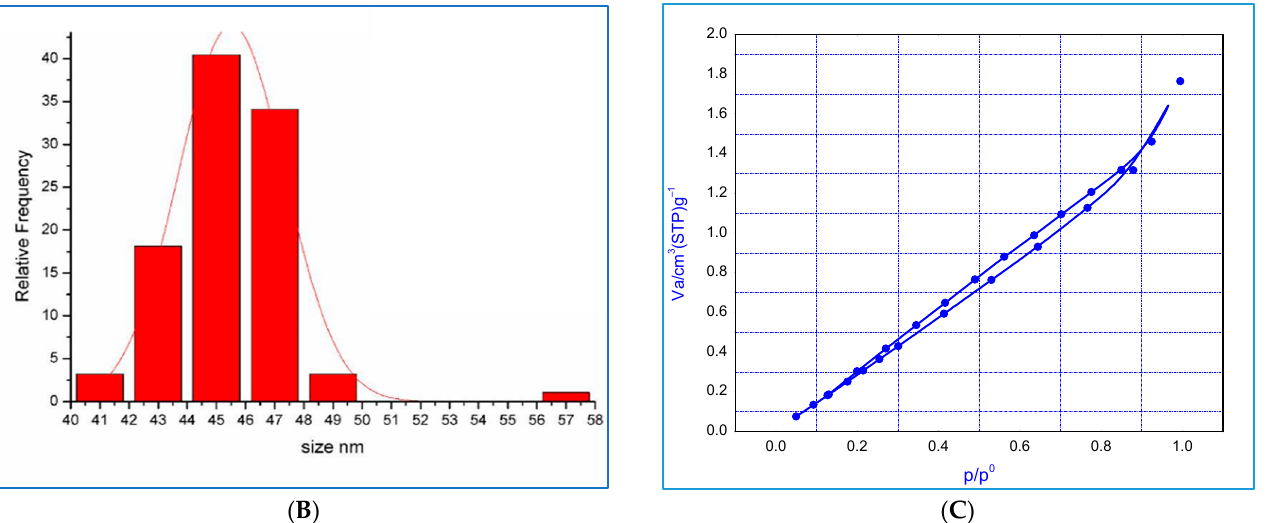
Figure 5. ( A ) TEM analysis of the ZVFe–Cu/Alg–LS nanocomposite ( B ) particle size distribution for